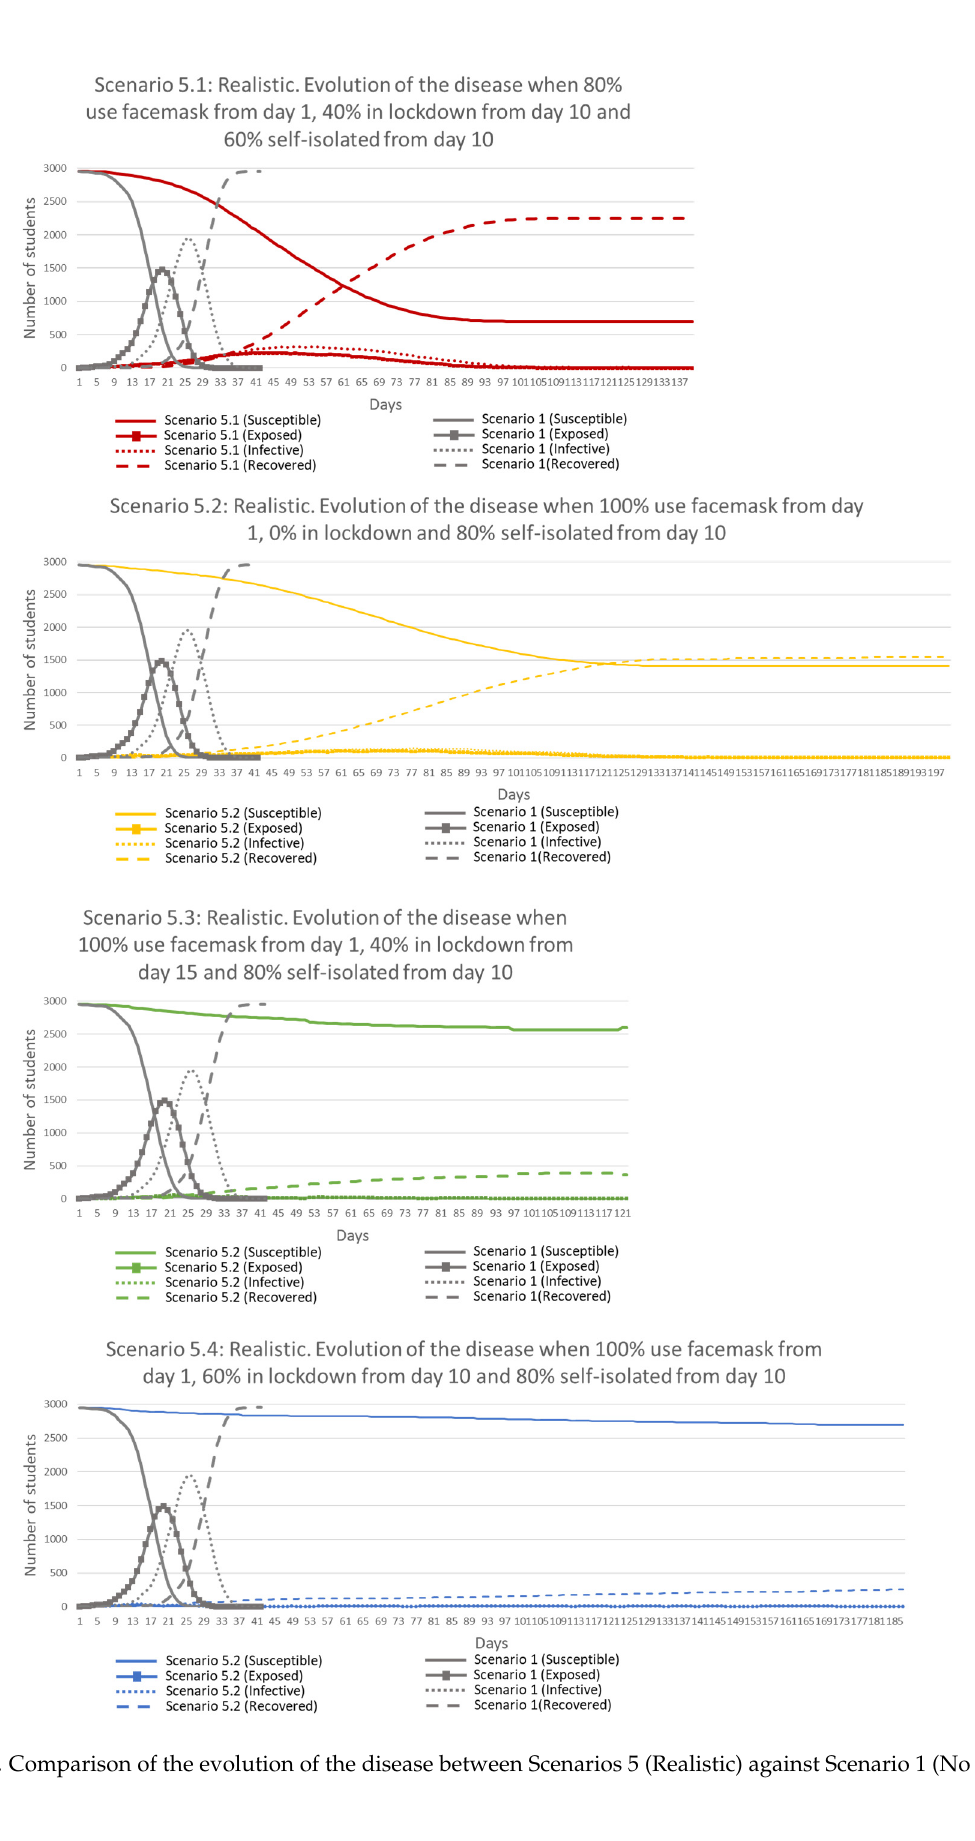
Figure A4. Comparison of the evolution of the disease between Scenarios 5 (Realistic) against Scenario 1 (No Measures).